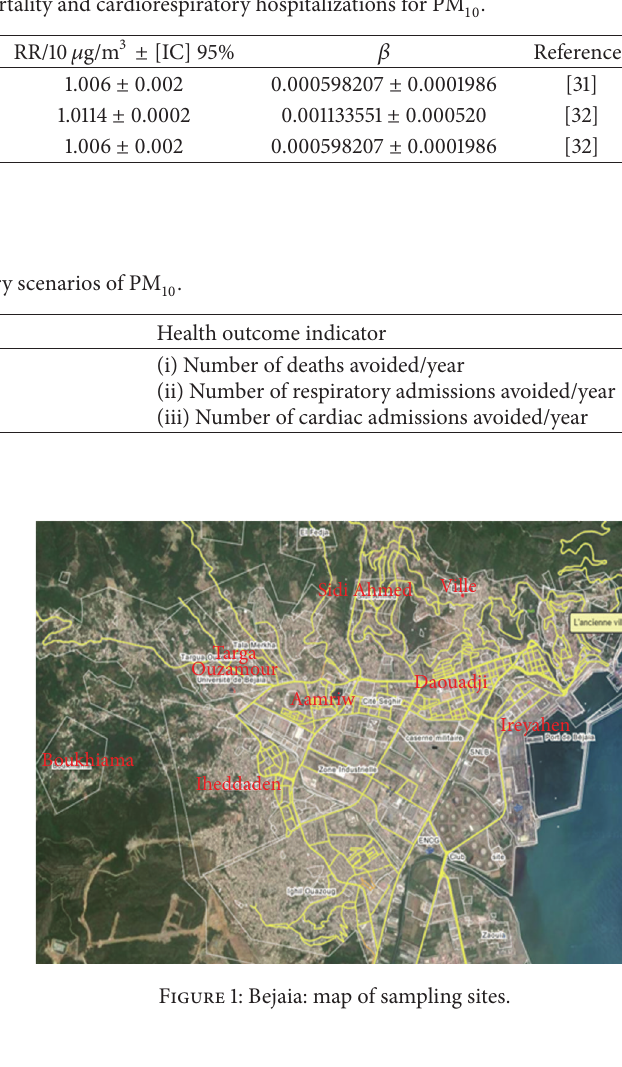
Table 1: Relative risks for nonexternal all-cause mortality and cardiorespiratory hospitalizations for PM 10 .